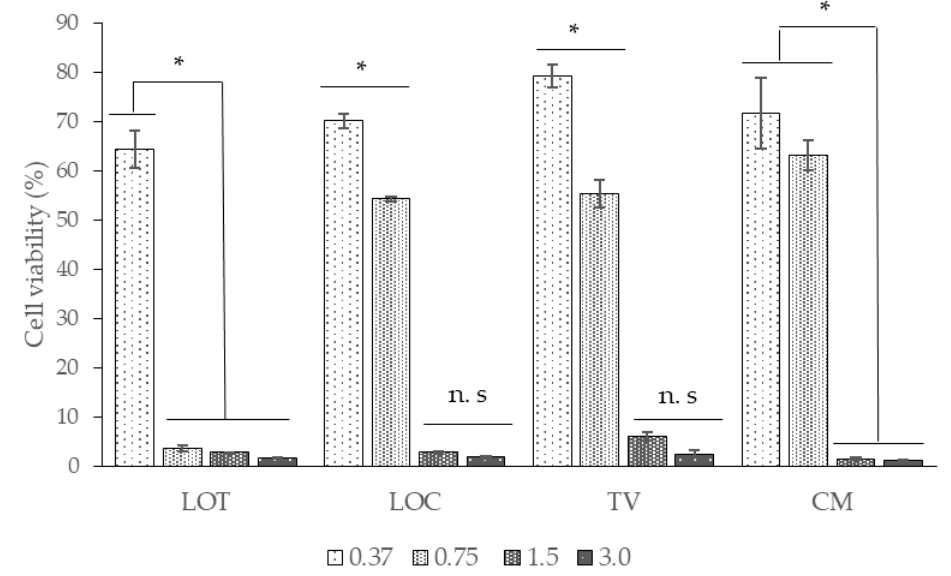
Figure 1. Cell viability assay of Vero cells treated with the EOs obtained from LOT, LOC, TV, and CM. Data are present as the means ± standard deviation. Asterisks indicate significant differences among concentrations of each EO assessed (* p < 0.05; n. s, no significant; multiple range test). Table 4. Selectivity index (SI) of the EOs in E. coli O157:H7 (EC), SARM (SA).